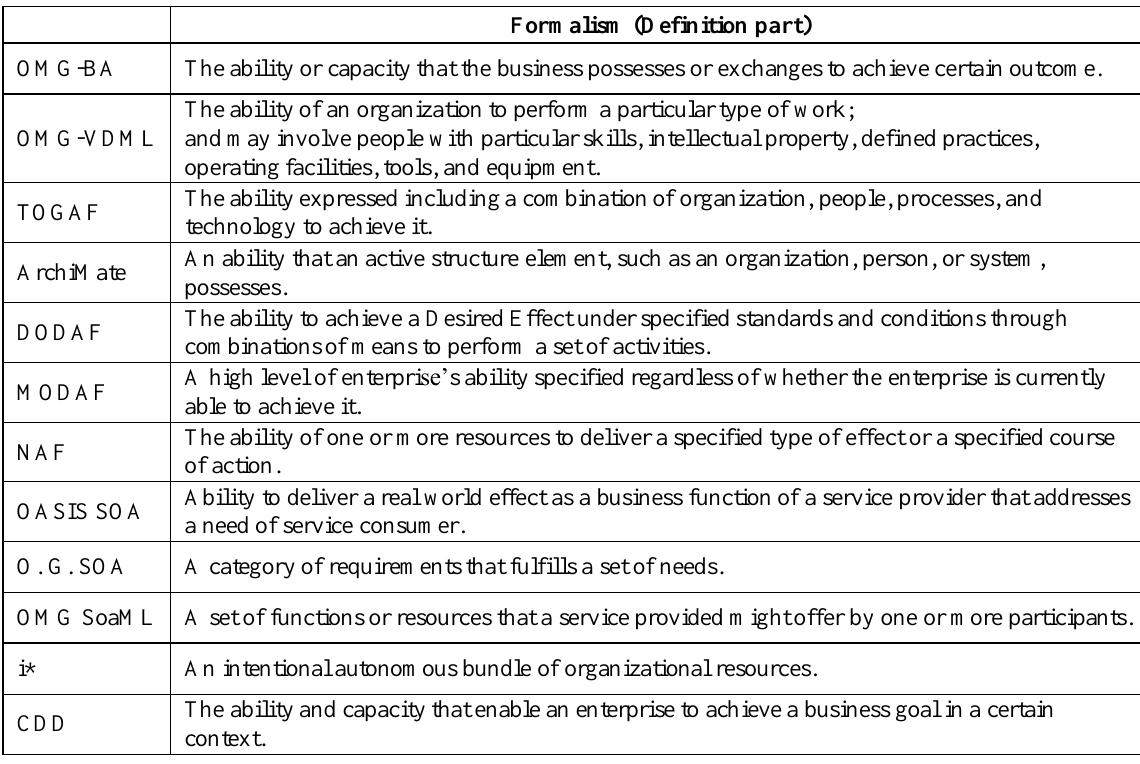
Table 2. The “Formalism” aspect of the capability concept Formalism (Definition